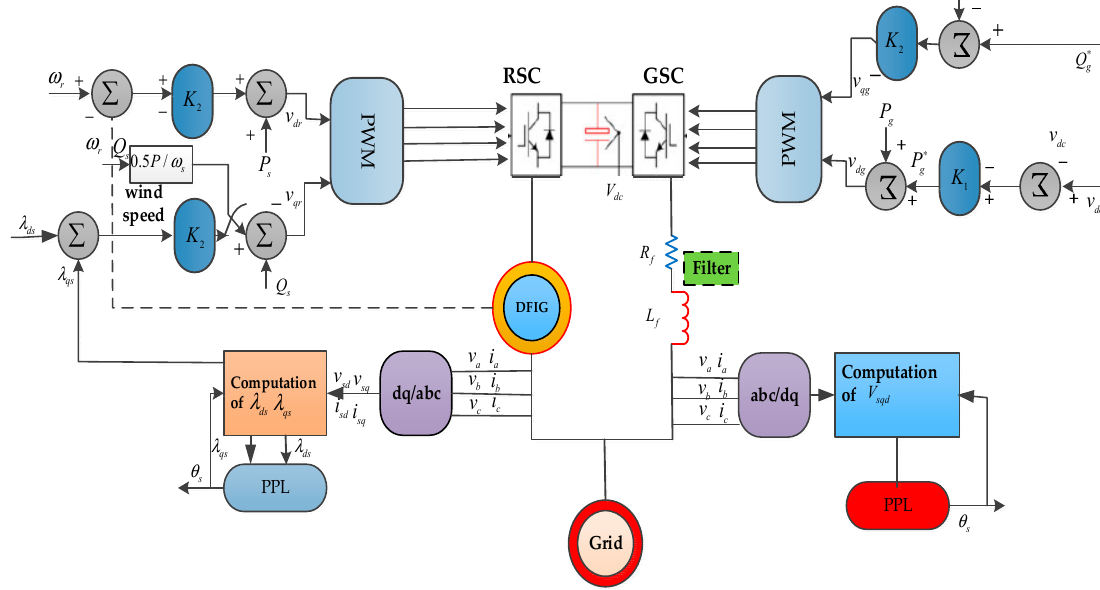
Figure 3. Over all control diagram and study system of the non-linear dynamic model of the DFIG. where: